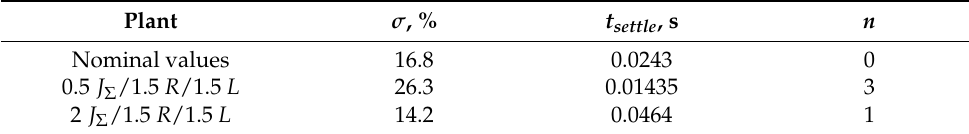
Figure 4. Speed transient curves obtained from conventional cascade control system. Table 1. Control quality